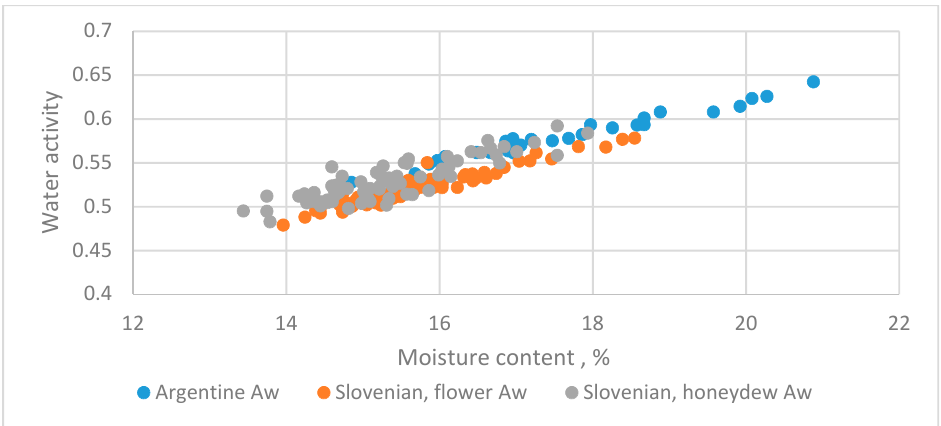
Figure 8. The relationship between water activity and moisture content of flower and honeydew honey from Argentinian [7] and Slovenia [5].